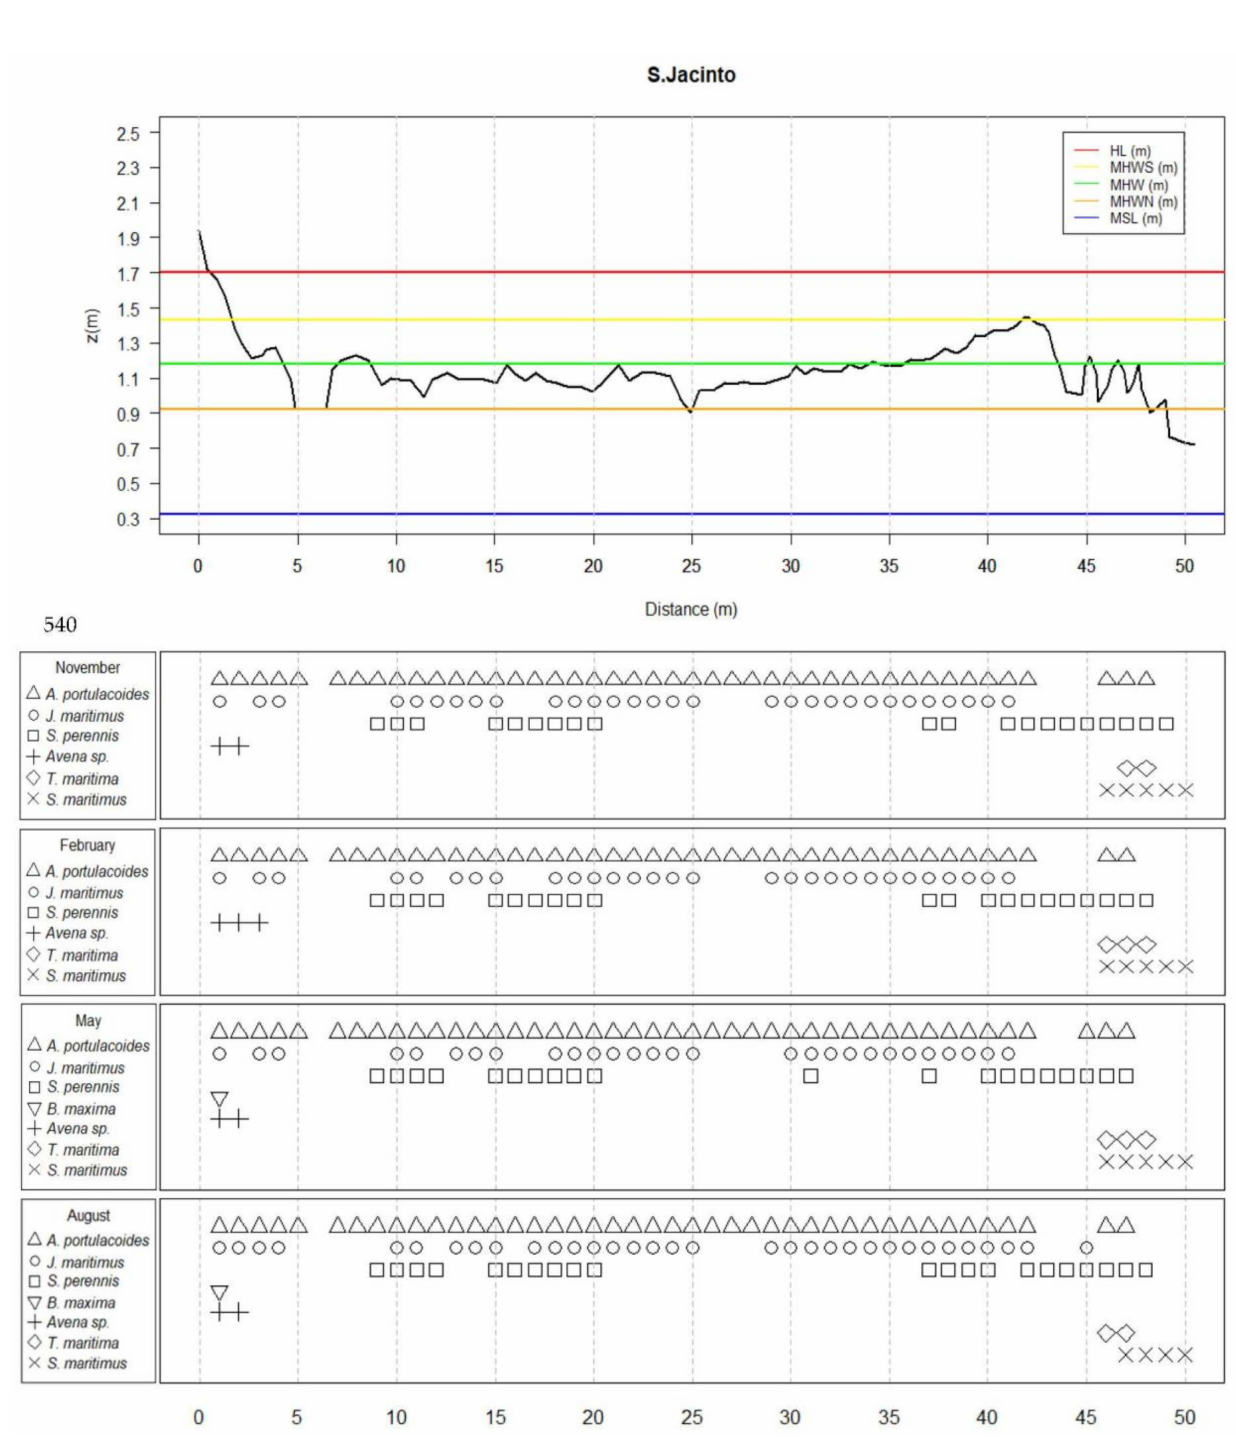
Figure A2. Topographic profile of S ã o Jacinto ´ s saltmarsh and its respective tidal levels. HL (highest tidal level), MHWS (mean high water springs), MHW (mean high water), (mean high water neaps), MSL (mean sea level). Representation of vegetation distribution through the length of the